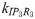
Sensitivity analysis of the model parameters.Percentage changes in Ca2+ wave (A) peak amplitude, (B) time to peak, (C) Ca2+ wave width at half maximum, and (D) end Ca2+ concentration at 90 seconds’ time point due to changes in model parameters kIP3R3, kRyR, VPump, KPump, JLeak, θ, L, α4, InIP3, InCa2+, DIP3, and DCa2+as marked in the x-axis. The analysis was carried out in NB layers NB1, NB5 and NB10 as denoted in (A) for parameter kIP3R3. The amount of modification (-25%, -10%, +10% or +25%) is shown in the grayscale of the histogram. The histogram bar is marked with asterisk (*) if the change was greater than 50%, and with double asterisk (**) if parameter modification did not result typical Ca2+ waveform. Regarding each Ca2+ wave feature, the parameter is illustrated only if the change was more than 5%.